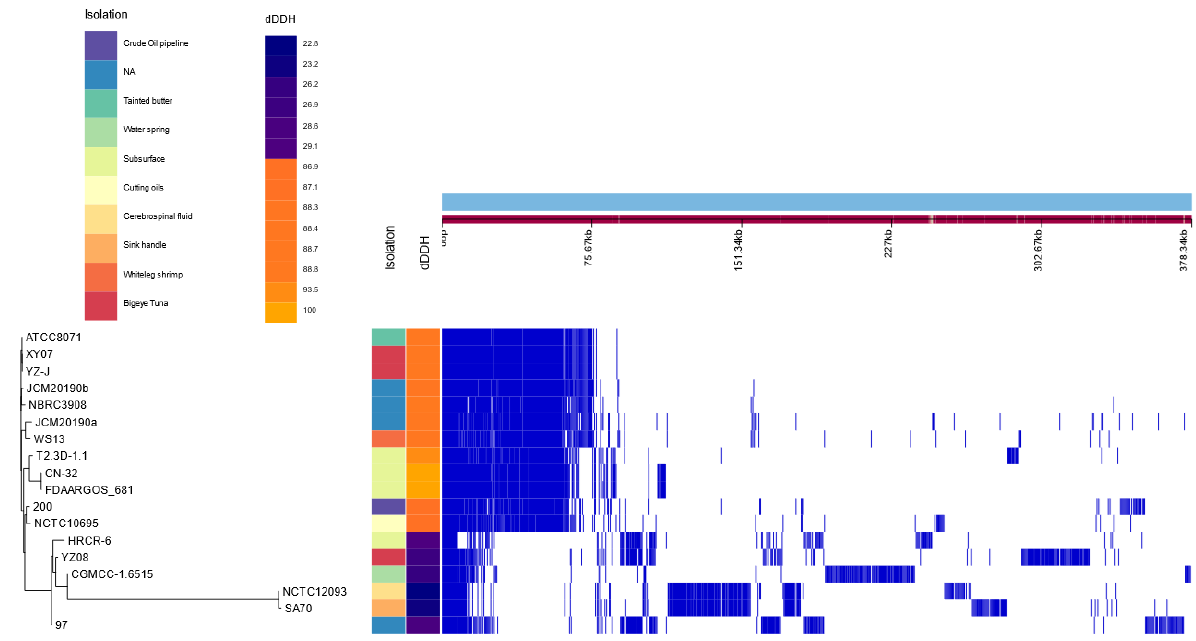
Figure 2. Graphical representation of the pangenome obtained from all available S. putrefaciens strains including Shewanella T2.3D-1.1. Additional columns show the isolation source and dDDH values when using Shewanella T2.3D-1.1 as the query genome. Isolation sources are represented in different colours. dDDH range from blue for the lowest values, to orange for the highest values using Shewanella sp. T2.3D-1.1 as the reference. Legend for each additional column is displayed on the top left corner.